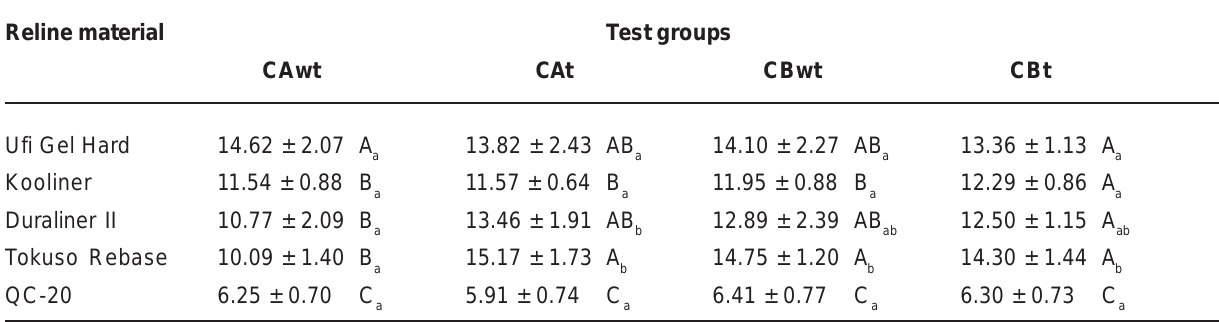
Vertically, identical capital letters indicate no significant differences ( P >.05) among reline materials. Horizontally, identical subscript small letters indicate no significant differences ( P >.05) among test TABLE 4- Type of failure (%) between reline materials and denture base resin